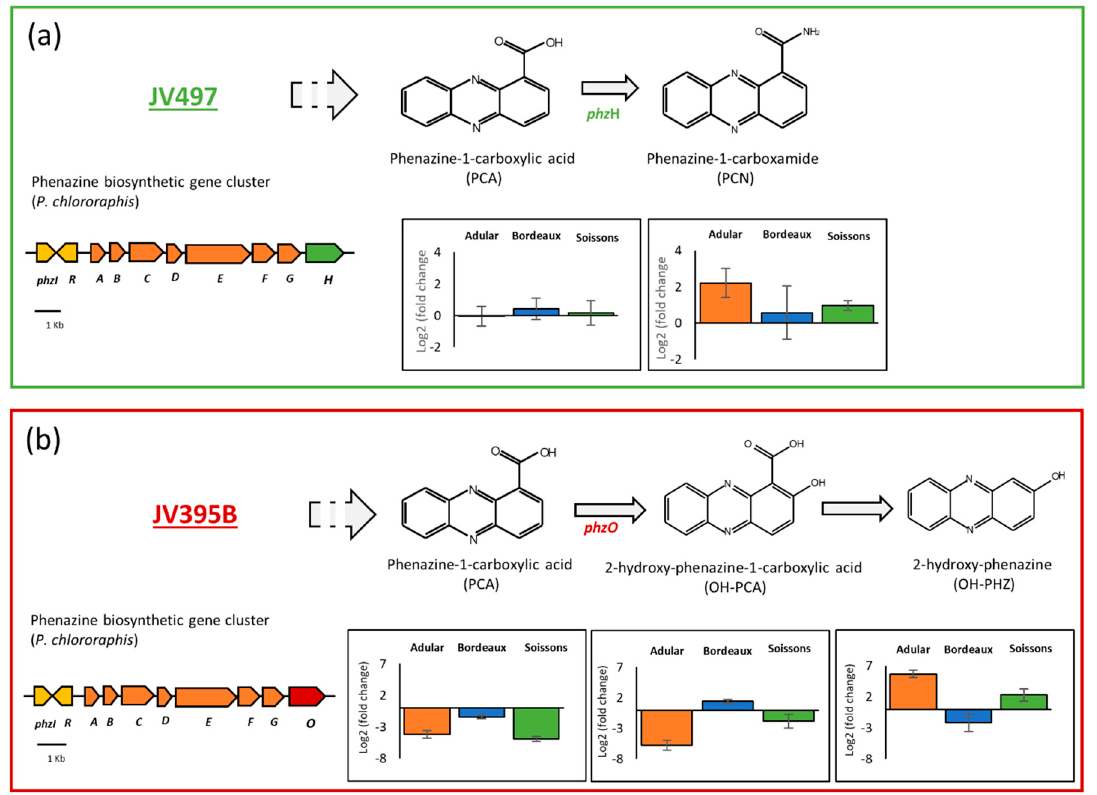
Figure 4. Plant metabolites interfere with the biosynthesis of phenazine-1-carboxylic (PCA) derivatives. The figure displays, for Pseudomonas chlororaphis JV497 ( a ) and JV395B ( b ), the phenazine biosynthetic pathway (adapted from Chin-A-Woeng et al. (2003) [29]), the organization of the phenazine biosynthetic operon in Pseudomonas chlororaphis JV497 ( a ) and JV395B ( b ), and the relative intensities (Log2 fold changes) of phenazine derivatives of Pseudomonas cultivated in the presence of wheat root extracts compared to the control condition (culture in the absence of root extracts) (n = 5 replicates).